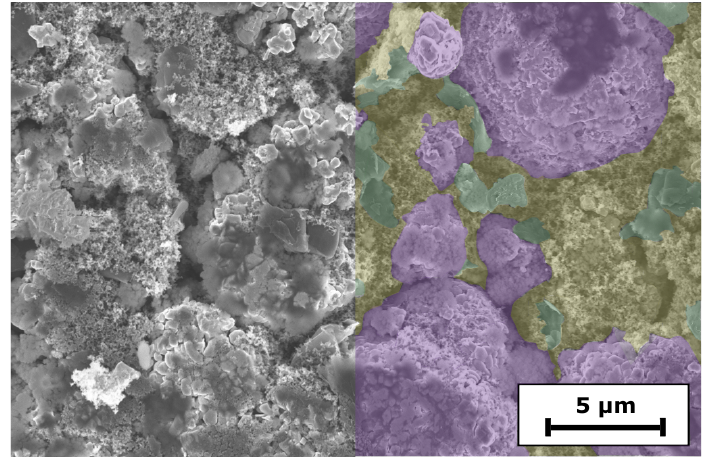
Figure A2. Top-view SEM image of 0PMA. Species are colored in purple (NMC811), green (KS6L graphite), and yellow (CBD).